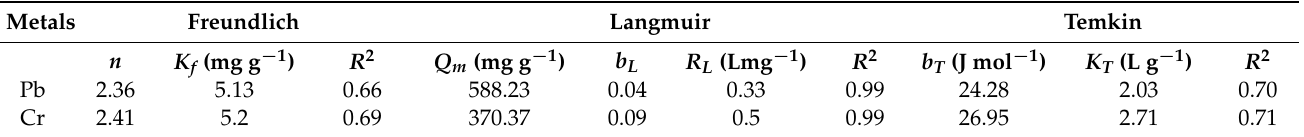
Table 1. Adsorption isotherm models parameters.